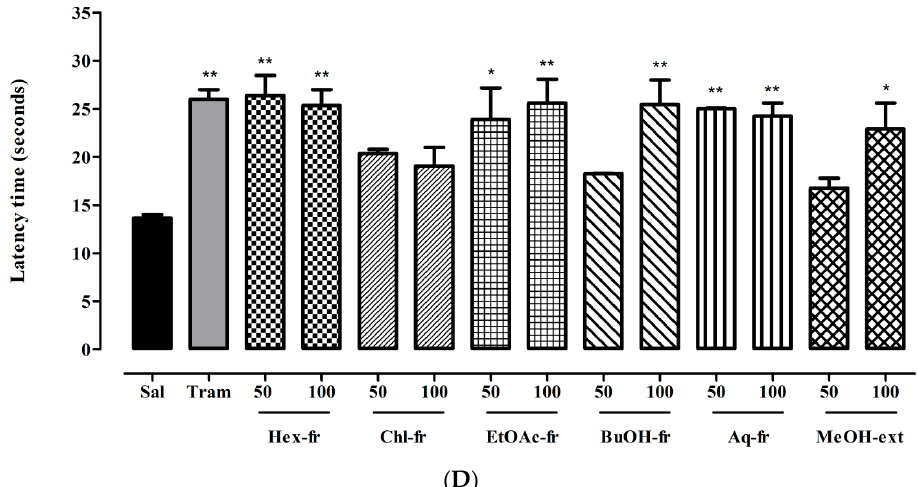
Figure 3. ( A ) Antinociceptive effect of Trillium govanianum rhizomes MeOH-extract its fractions (mg/kg) after 30 min. Sal, saline solution; Tram, tramadol; ( B ) Antinociceptive effect of Trillium govanianum rhizomes MeOH-extract its fractions (mg/kg) after 60 min. Sal, saline solution; Tram, tramadol; ( C ) Antinociceptive effect of Trillium govanianum rhizomes MeOH-extract its fractions (mg/kg) after 90 min. Sal, saline solution; Tram, tramadol; ( D ) Antinociceptive effect of Trillium govanianum rhizomes MeOH-extract its fractions (mg/kg) after 120 min. Sal, saline solution; Tram, tramadol. ANOVA followed by Dunnett’s post hoc test: * p < 0.05, ** p < 0.01, *** p < 0.001 compared to saline treated group; N = 6.